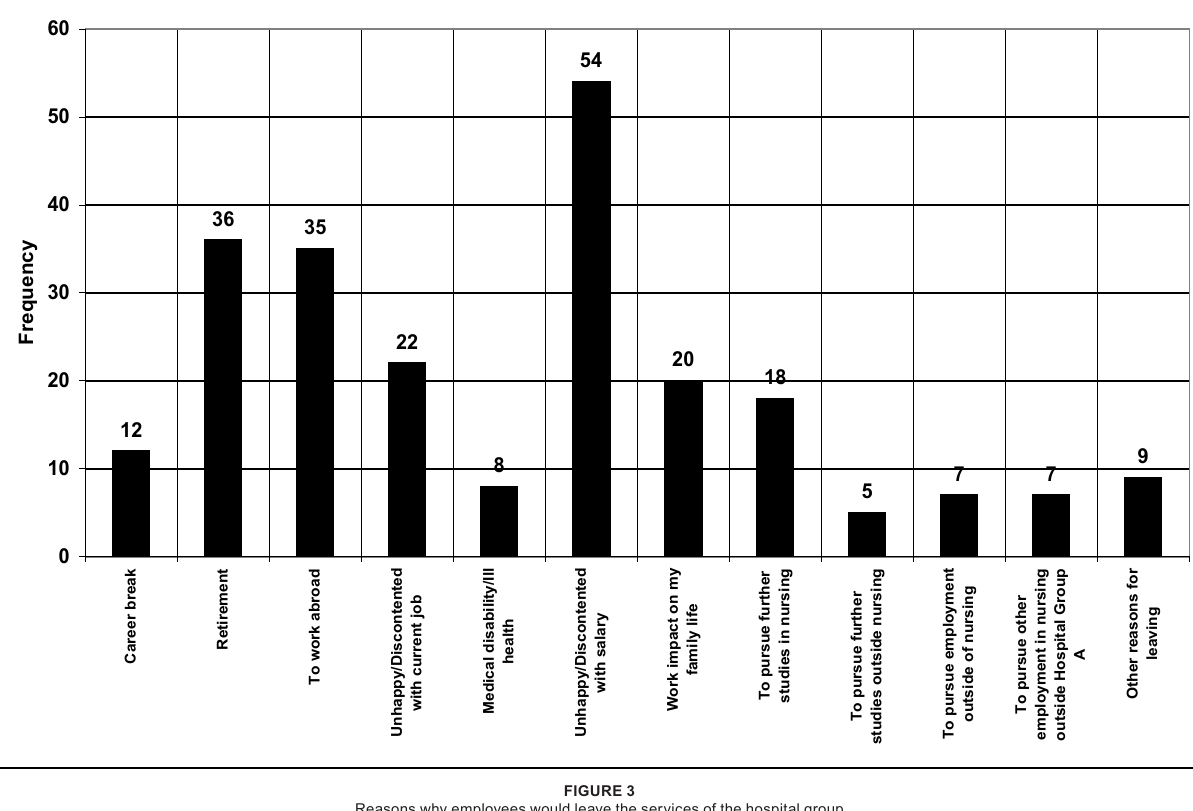
FIGURE 3 Reasons why employees would leave the services of the hospital